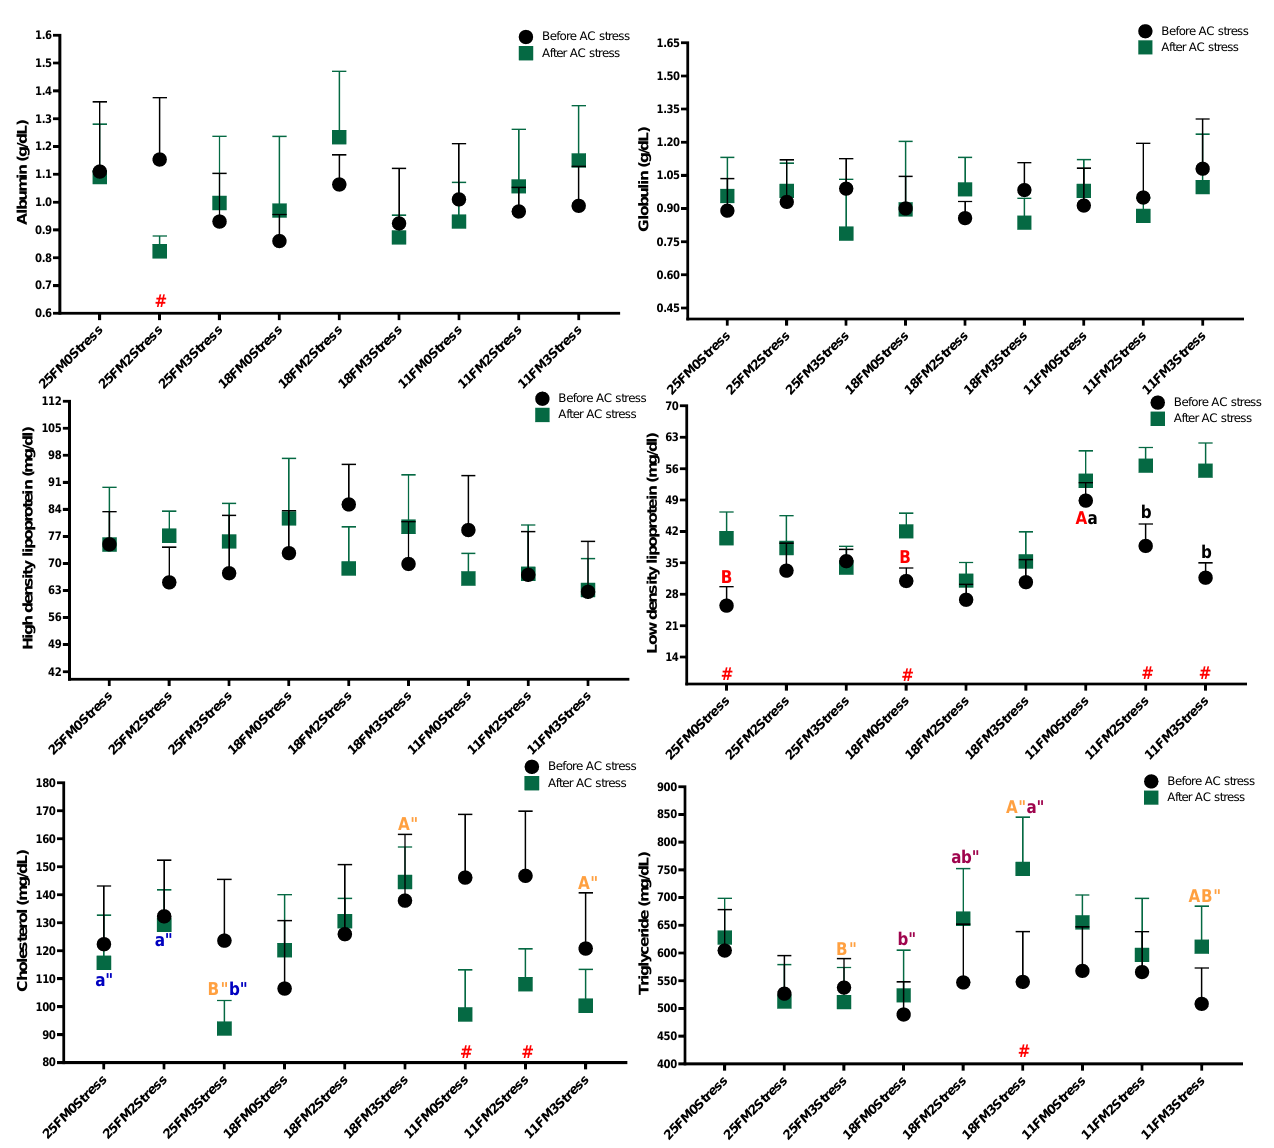
Figure 2. Blood biochemistry parameters of oscar fed experimental diets containing different levels of FM and exposed to secluded early mild stress for ten weeks plus data related to after acute confinement stress (AC stress). Values are represented by means and SDM of triplicate samples. Hash (#) with red colour indicates the significant difference in each treatment before and after AC stress according to the independent sample t -test ( p < 0.05). The letters A, B and C with red, brown and orange indicate significant differences among 0Stress, 2stress and 3Stress groups after unpacking the data for the case that interaction was significant. The letters a, b and c in blue, pink and black indicate significant differences among the 25FM, 18FM and 11FM groups. The double quotation marks show that the comparison was among after AC stress groups.